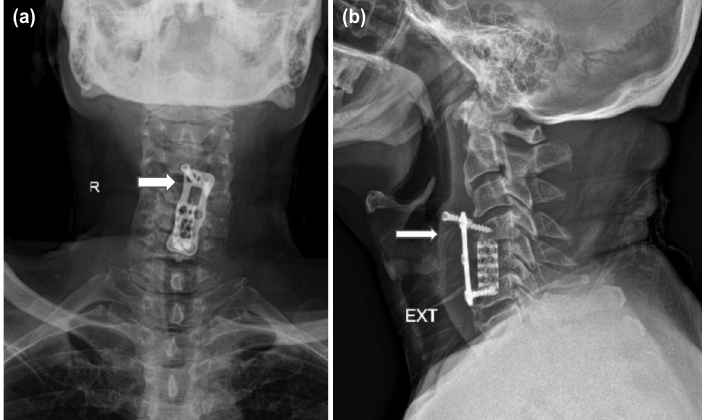
Radiographs of cervical spine with (a) AP view showing back-out of right sided proximal screw of cervical plate as denoted by Fig. 1: white arrow with plate shifted to left, (b) lateral extension view showing one of proximal screws completely backed-out, marked with white arrow of anterior cervical plate with other one partially backed-out.